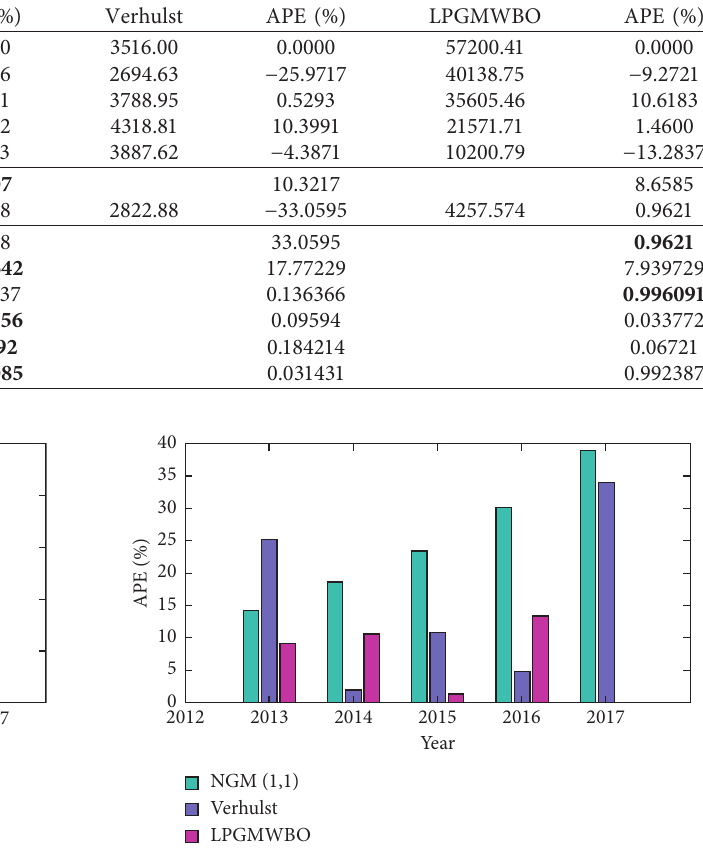
Figure 3: The APE of the three models for validation of Shanghai data.